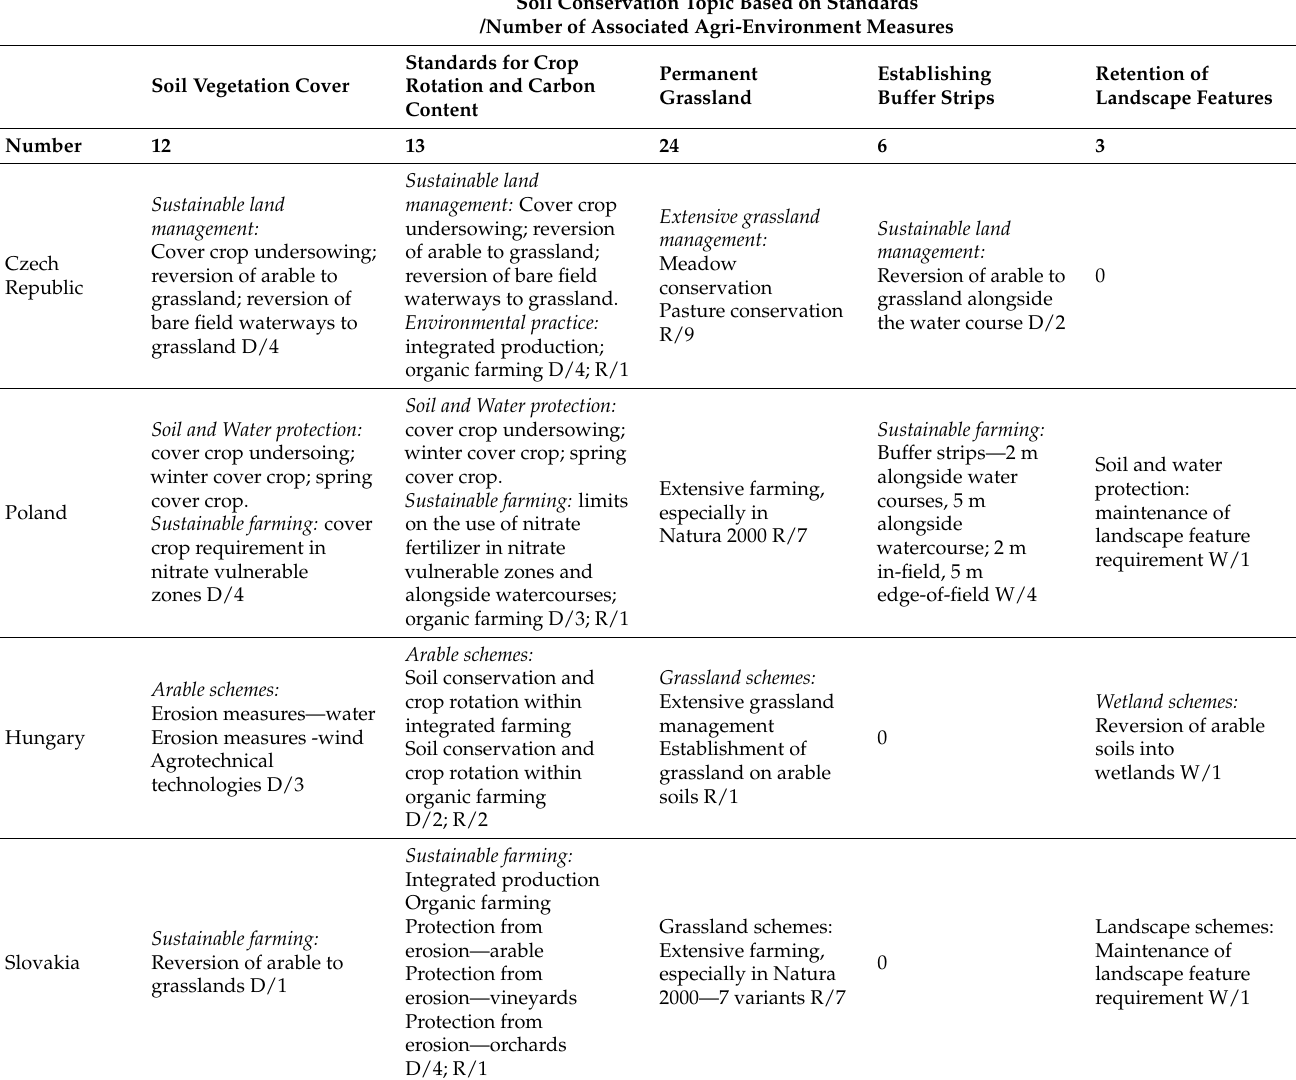
Table 3. Agri-environment schemes focusing on soil water and soil carbon sequestration according to the basic soil